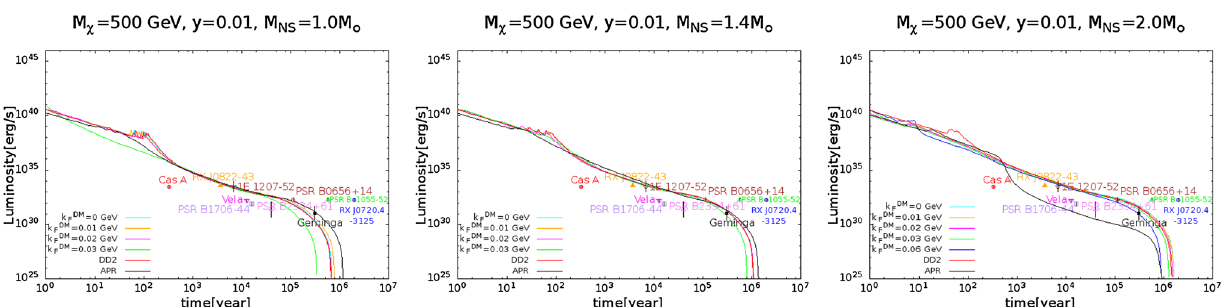
Fig. 5 Same as in Fig. 4 but for M χ = 200GeV